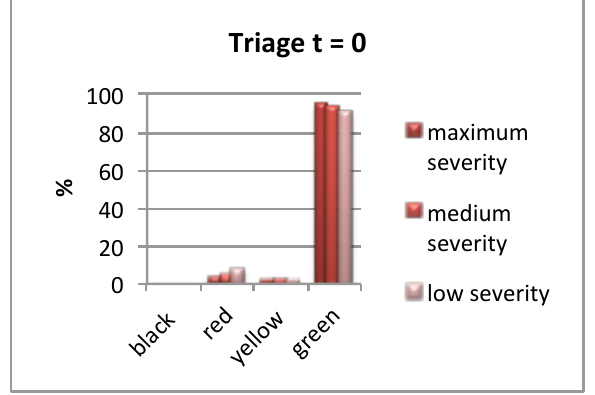
Fig. 3. Percentage of color code triage (black, red, yellow, green) for each event severity level (maximum, medium, low) at initial time of event